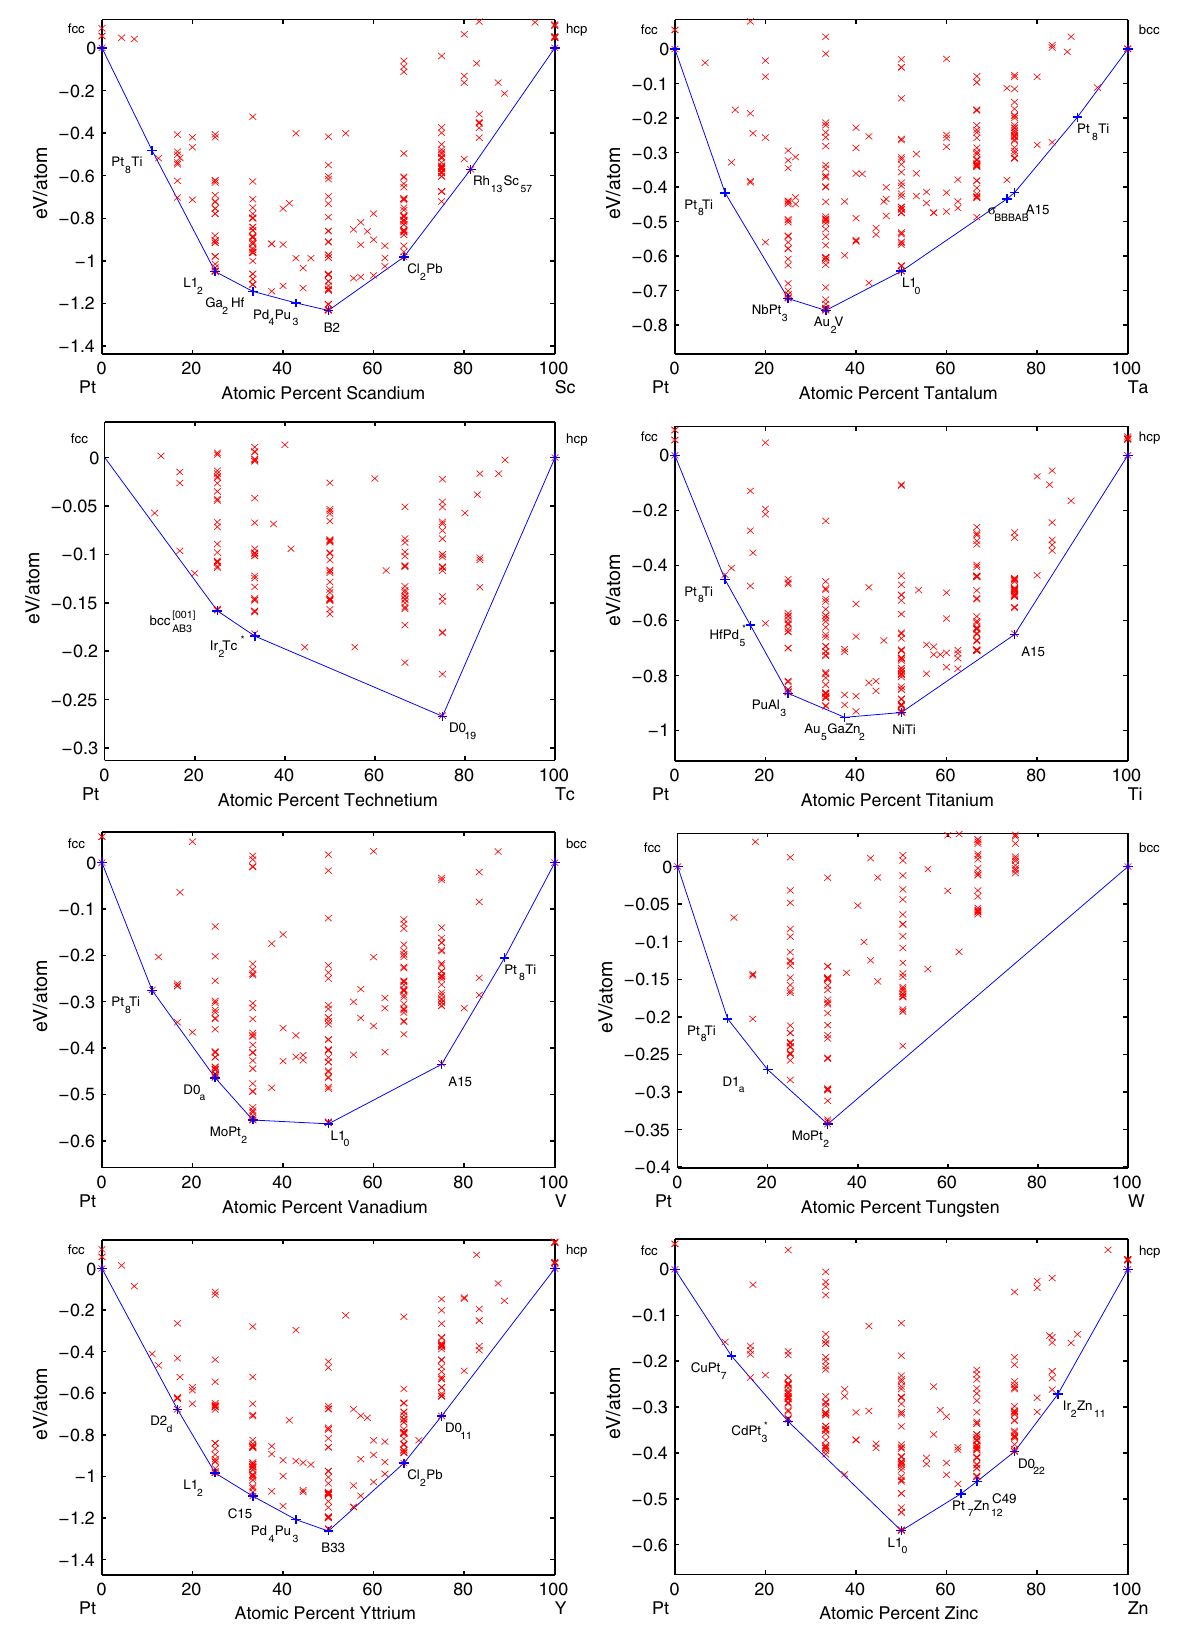
FIG. 16. Convex hulls for the systems Pt-Sc, Pt-Ta, Pt-Tc, Pt-Ti, Pt-V, Pt-W, Pt-Y, and